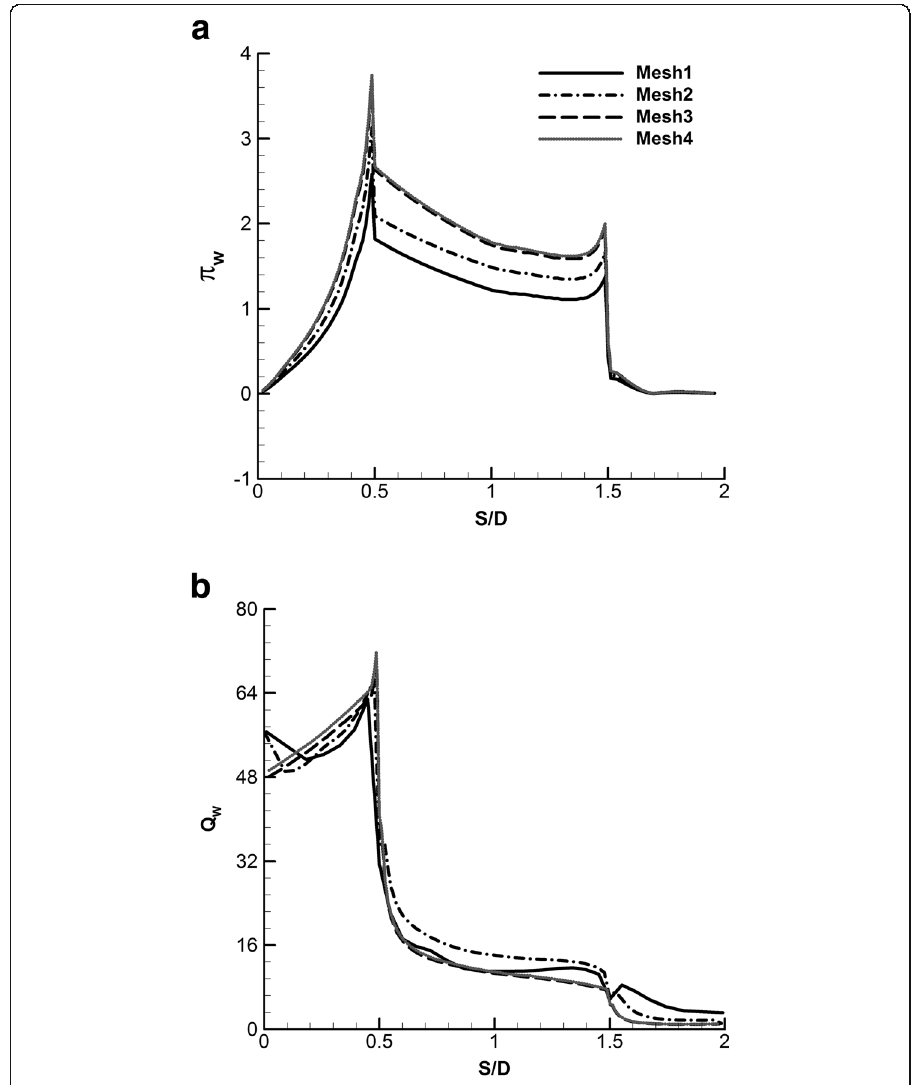
Fig. 3 Comparison of normalized quantities measured along the surface of the square cylinder for different meshes at Kn = 0.005 and M = 5.0: a shear stress, and b heat